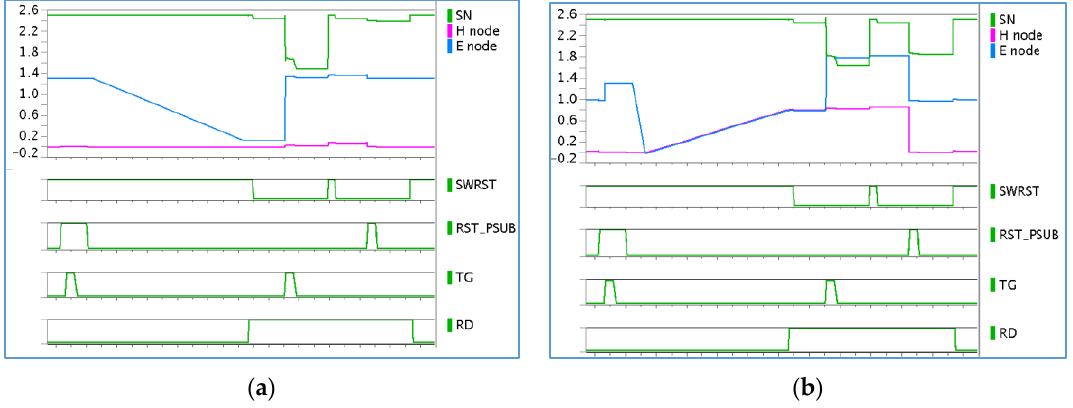
Figure 4. Pixel simulation. Signal: 30 k ( a ); 400 k ( b ). SN: Sense node.